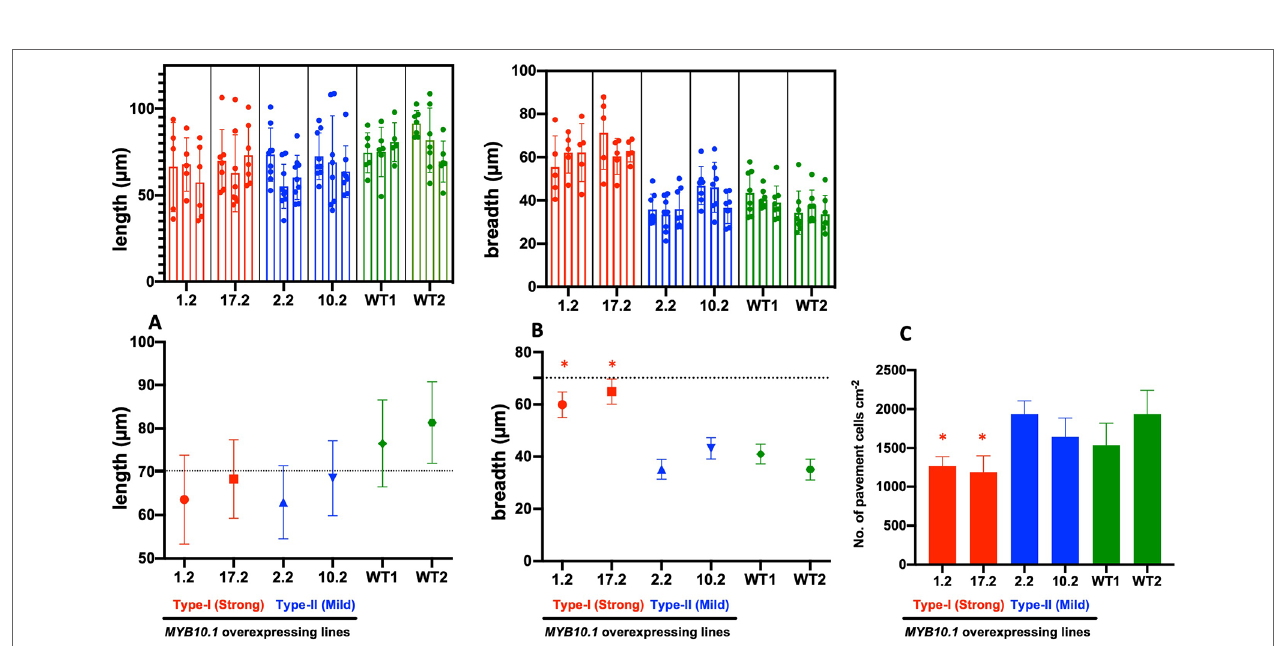
FIGURE 3 | Analysis of the leaf epidermal (adaxial surface) cells of transgenic tobacco lines. Length of the pavement cells (A) , breadth of the pavement cells (B) , and number of the pavement cells cm−2 (C) of the tobacco leaf adaxial epidermis. Length and breadth were measured using the ImageJ software program (Schneider et al., 2012) on photographs taken by ESEM. In the top row of panels A and B , data are presented for at least five cells (dots) from each plant (column, mean ± SE) of the three used for each independent line (a block for each line); two lines were used for each phenotype (a different color for each phenotype, red for type I and blue for type II). In the bottom row, values are averaged according to the lines (mean ± SD), with the same color code as in the top row. Panel C describes the density of pavement cells per surface unit. In this case, data are presented only per single line. Asterisks indicate statistically different values (P < 0.05) from WT with a nested one-way analysis of variance